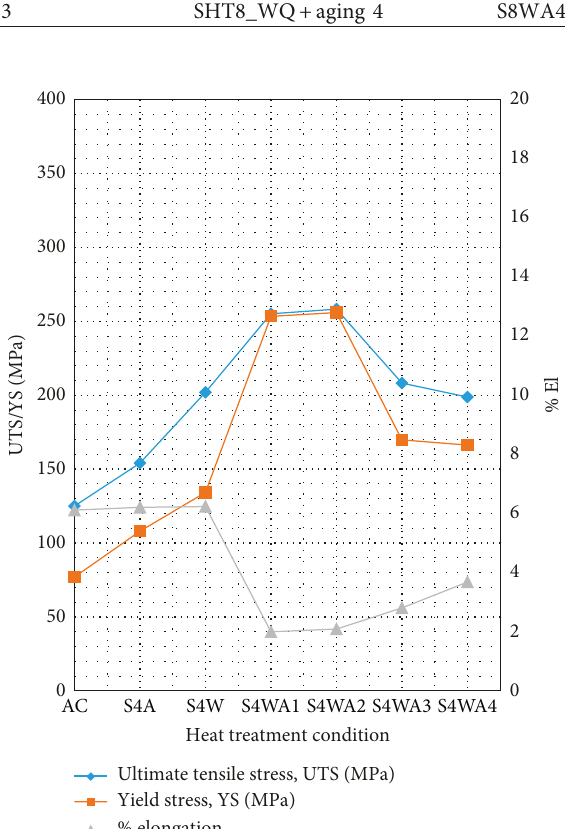
Figure 1: Average values of UTS, YS, %El for alloy A in the as-cast condition and after heat treatments comprising SHTfor 4h (tested at 250 ° C).